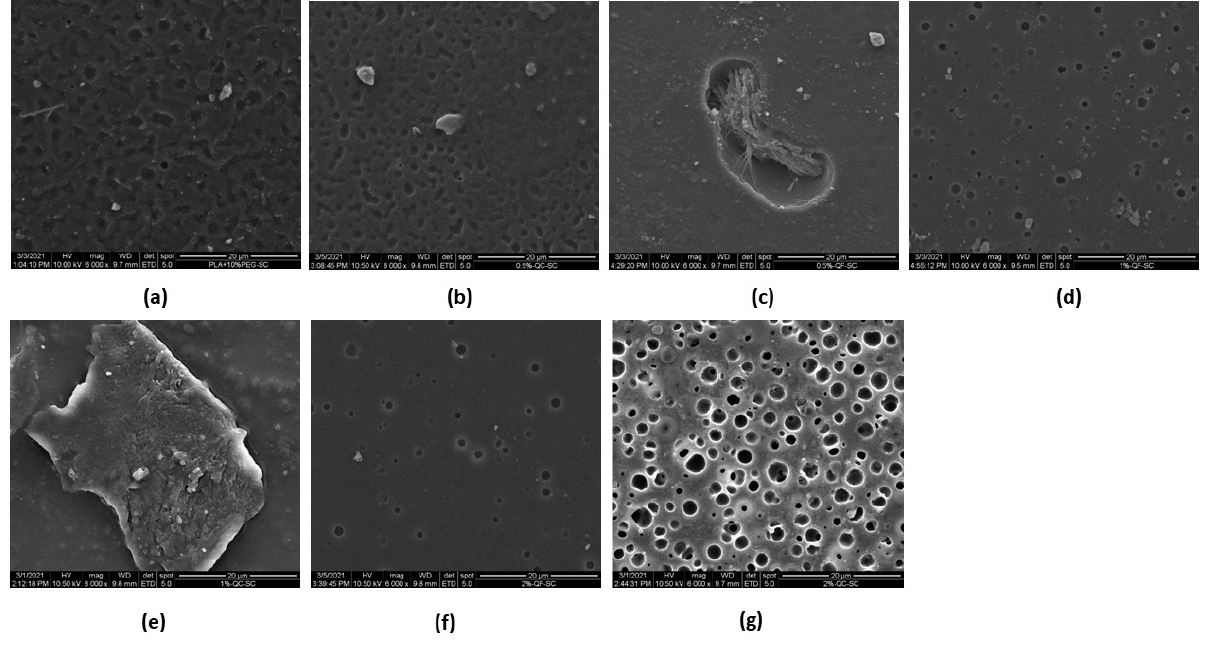
Figure 2. Image of the films ( a ) PLA ‐ PG; ( b ) PLA ‐ PG ‐ 50C; ( c ) PLA ‐ PG ‐ 50F; ( d ) PLA ‐ PG ‐ 100F; ( e ) PLA ‐ PG ‐ 100C; ( f ) PLA ‐ PG ‐ 200F and ( g ) PLA ‐ PG ‐ 200C.